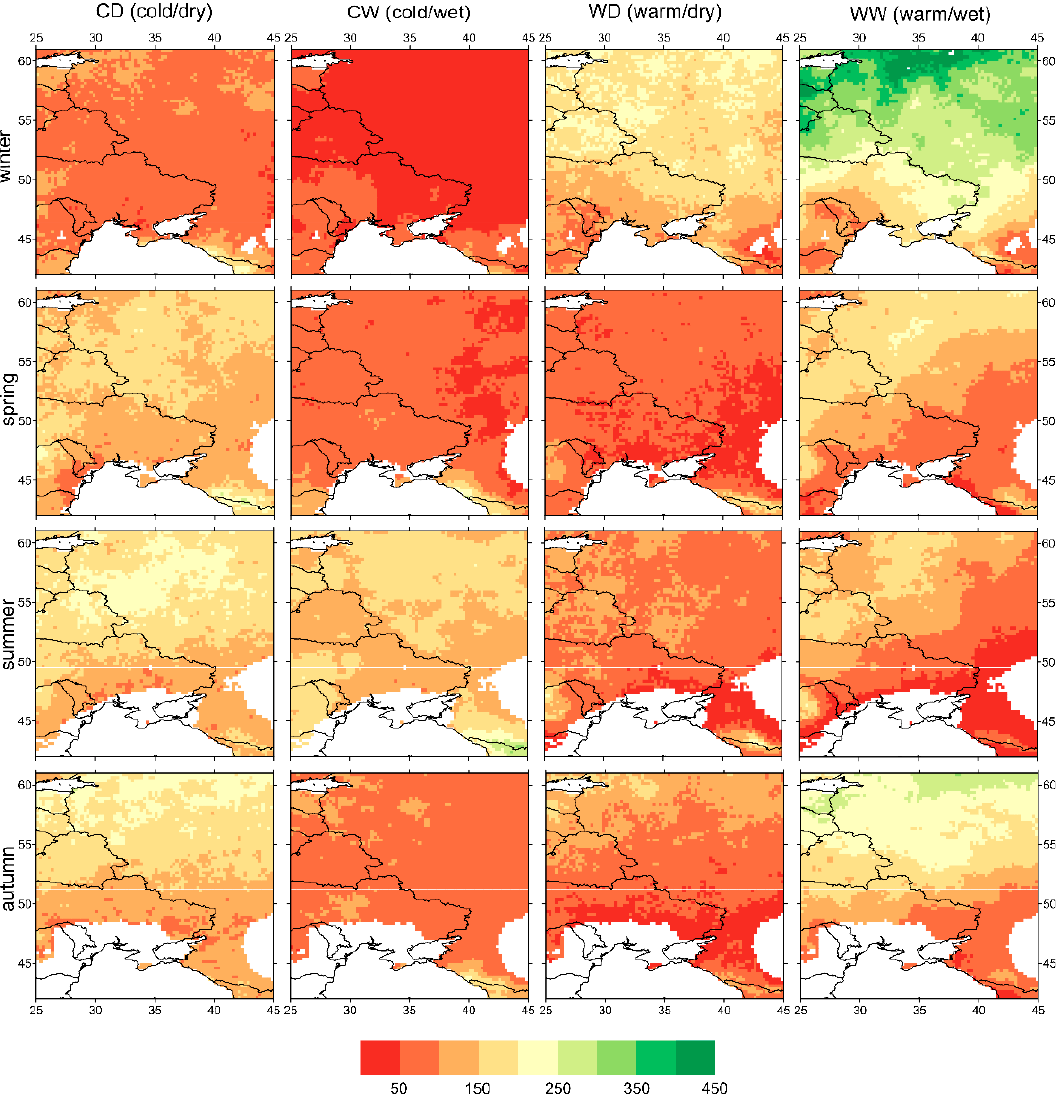
Figure 2. The spatial distribution of total number of days with compound air temperature and precipitation extremes over the period 1950–2018.